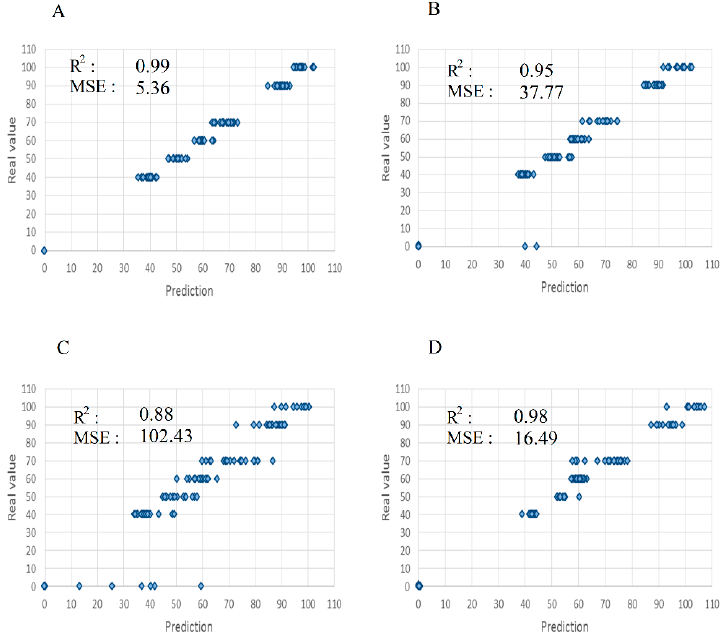
Figure 15. The real value of the indium content in the target (wt%) on the ‘y’ axis and the prediction of the indium content (wt%) of the target composition in the ‘x’ axis, R-squared (R2), and mean squared error (MSE) of the models predictions. ( A ) Original min max scaled spectral data turned into a 2D matrix, ( B ) SOM generated image, ( C ) SOM_SVD generated image from the first layer singular value decomposition reconstruction of the original data, ( D ): Original_SVD image generated from the first layer of the singular value decomposition reconstruction.